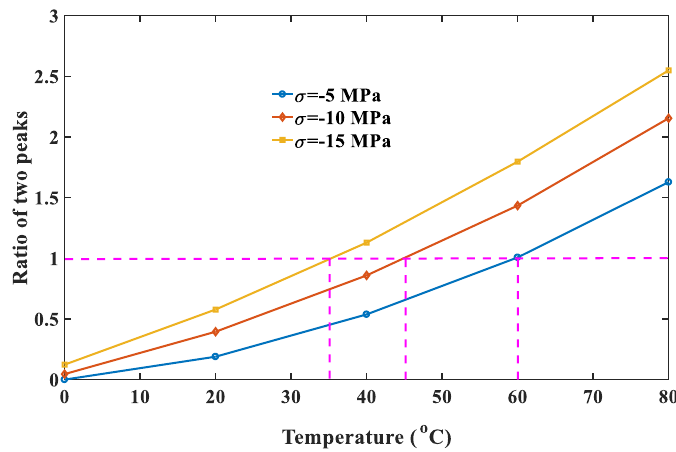
Figure 12. The ratio of the first peak to the second peak varied with temperature under different